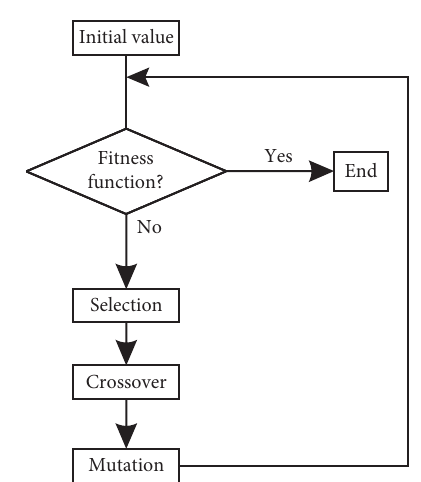
Figure 14: Calculation flow chart of GA.